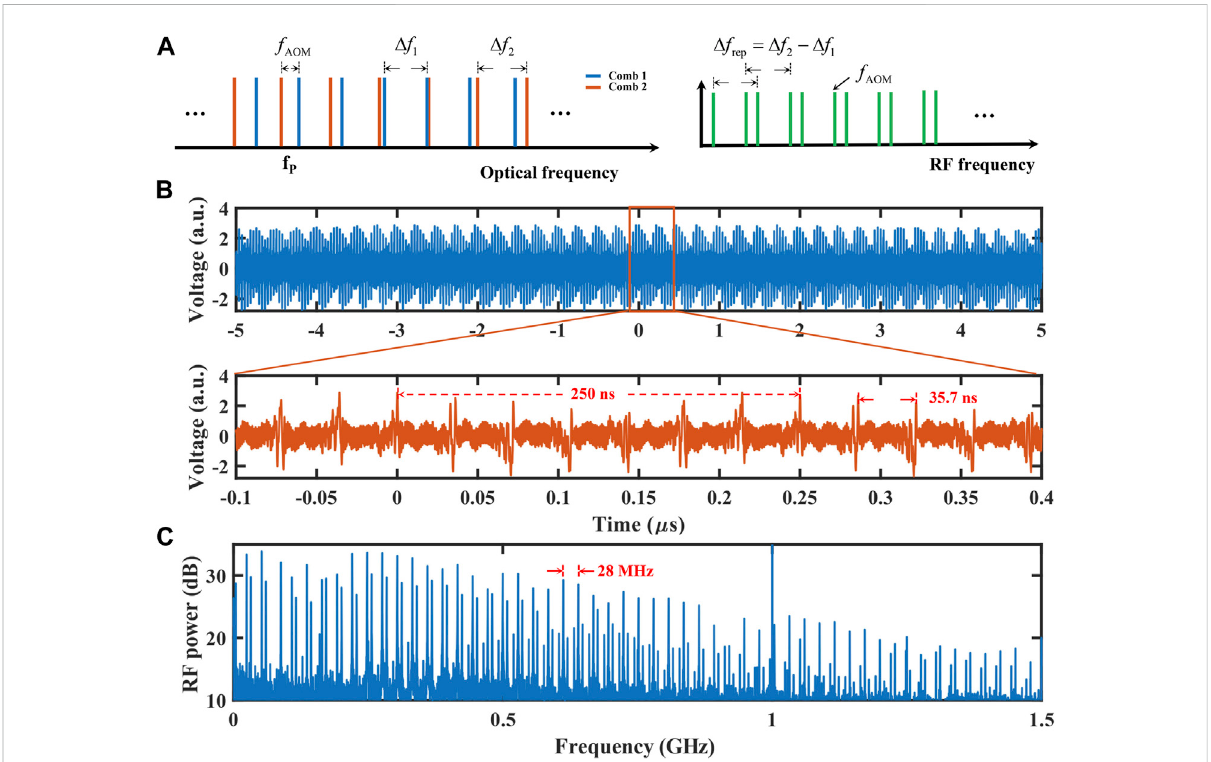
FIGURE 5 ExperimentalinterferogramsequenceandRFspectrum. (A) Schematicfordual-microcombspectruminopticaldomainandRFdomain. Δ f 1 and Δ f 2 aretherepetitionratesoftwomicrocombs. Δ f (B) Time-domain interferogram results of the dual-microcomb soliton pulses with the acquisition time of 10 µs. (C) The Fourier-transformed electrical spectrum of the time-domain